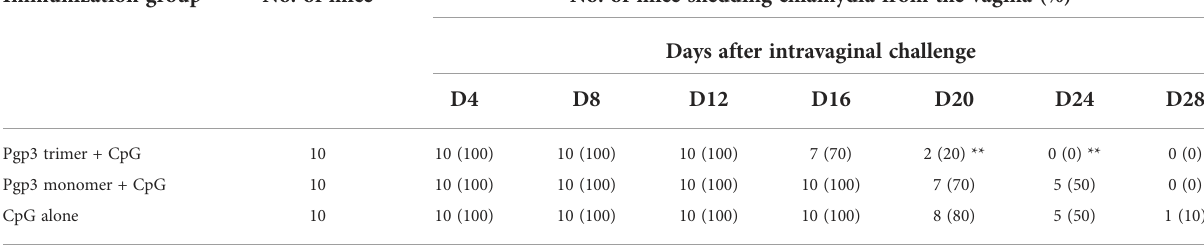
TABLE 1 Percentage of positive chlamydial shedding in diverse immunization groups. Immunization group No. of